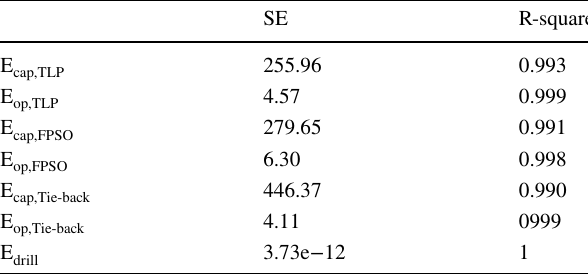
Table 19 Linear regression statistics for costs